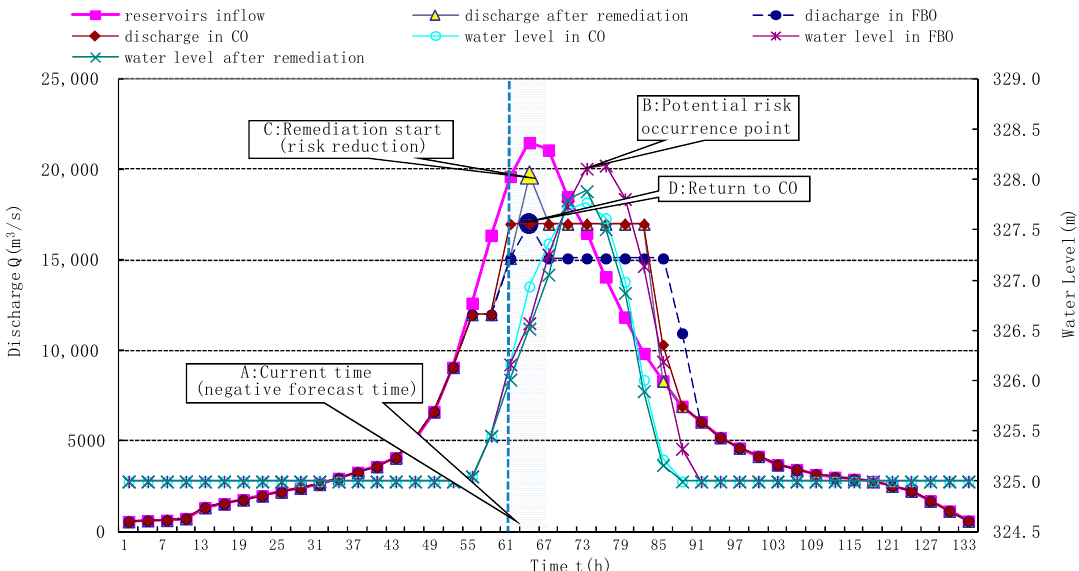
Figure 7. Schematic diagram of flood regulation risk reduction for significant forecast error in FBO.